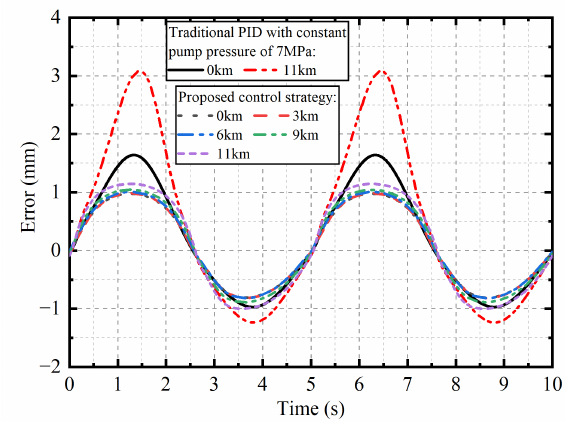
Figure 12. Tracking performance of harmonic movement.